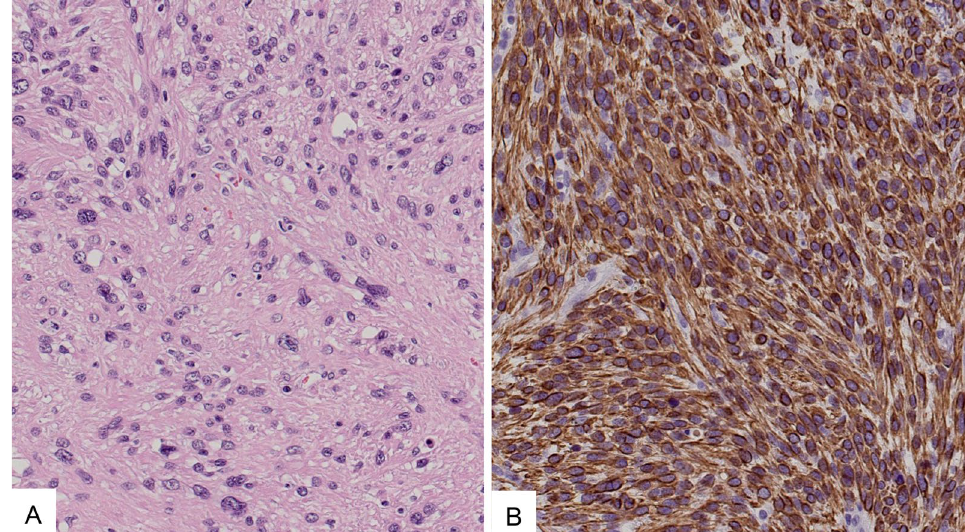
Fig. 3 A A histopathological examination of the lung nodule showing dense proliferation of spindle-shaped cells with an eosinophilic cytoplasm. B The tumor cells were immunohistochemically positive for desmin and were consistent with a metastatic